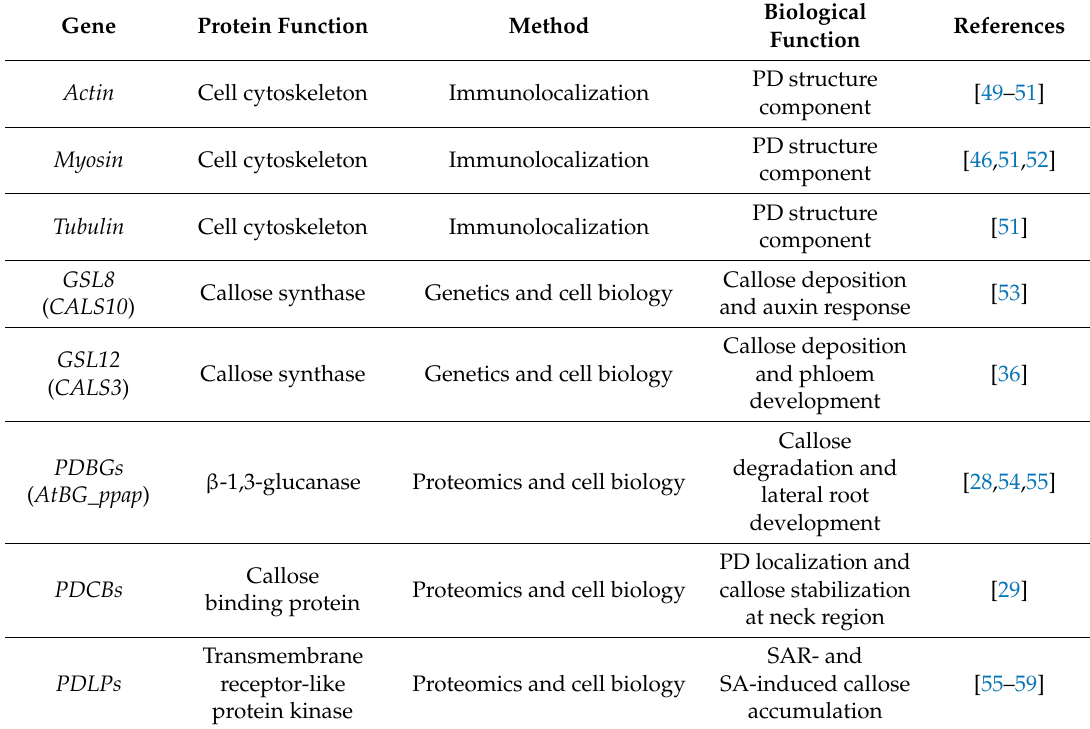
Table 1. Proteins associated with plasmodesmata